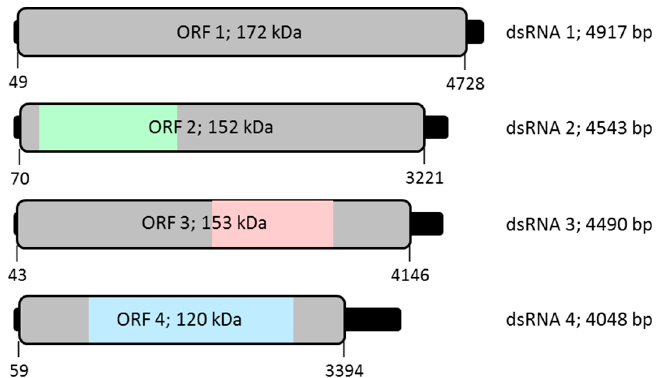
Figure 3. Schematic representation of the genomic organisation of LbQV-1. The LbQV-1 genome consists of four dsRNA segments, 4917, 4543, 4490, and 4048 bp in size, each containing one ORF shown as an open box flanked by 5 (cid:48) - and 3 (cid:48) -UTRs. A pink box on dsRNA 3 represents the RdRP domain. A blue and a green box on dsRNA 2 and dsRNA 4, respectively, illustrate the domains of the putative capsid proteins that were structurally modelled, as shown in Figure 2. Table 1. Features of the LbQV-1 dsRNA segments 1 – 4 and comparisons with other known and suspected quadriviruses.